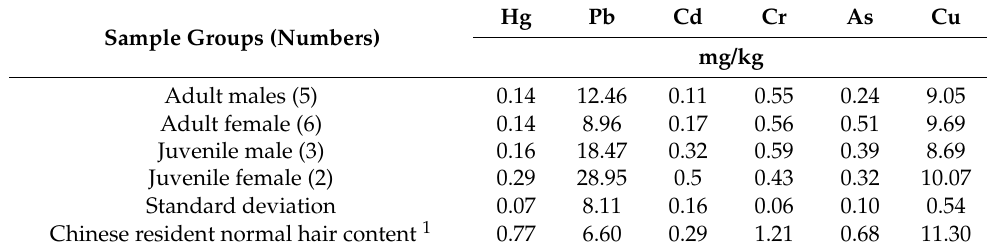
Table 1. The average contents of toxic trace elements in the human hair in the contrast area.